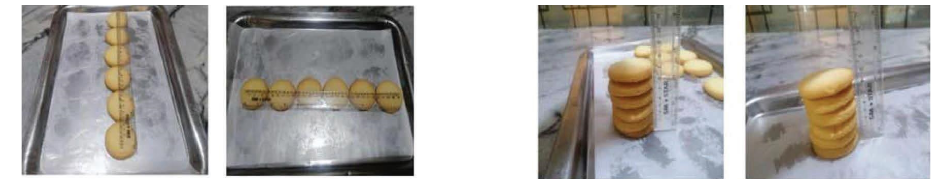
Figure 3: Measurement of width and thickness of developed